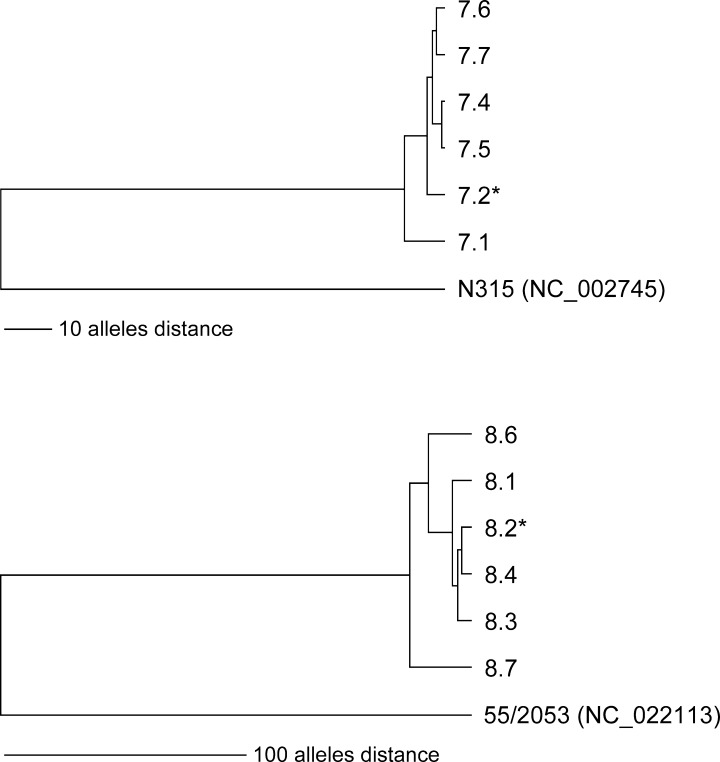
UPGMA-tree based on up to 1,861 cgMLST allelic profiles of S. aureus isolates of patients 7 and 8 (Table 2).The tree on the top shows the relationship of the six isolates of patient 7 including the reference strain N315, the tree on the bottom shows the relationship of the six isolates of patient 8 including the reference strain 55/2053. The scale, i. e. distances were given in absolute number of differing alleles. The strains marked with an asterisk exhibit a mucoid phenotype. For more information about isolates see Table 2.